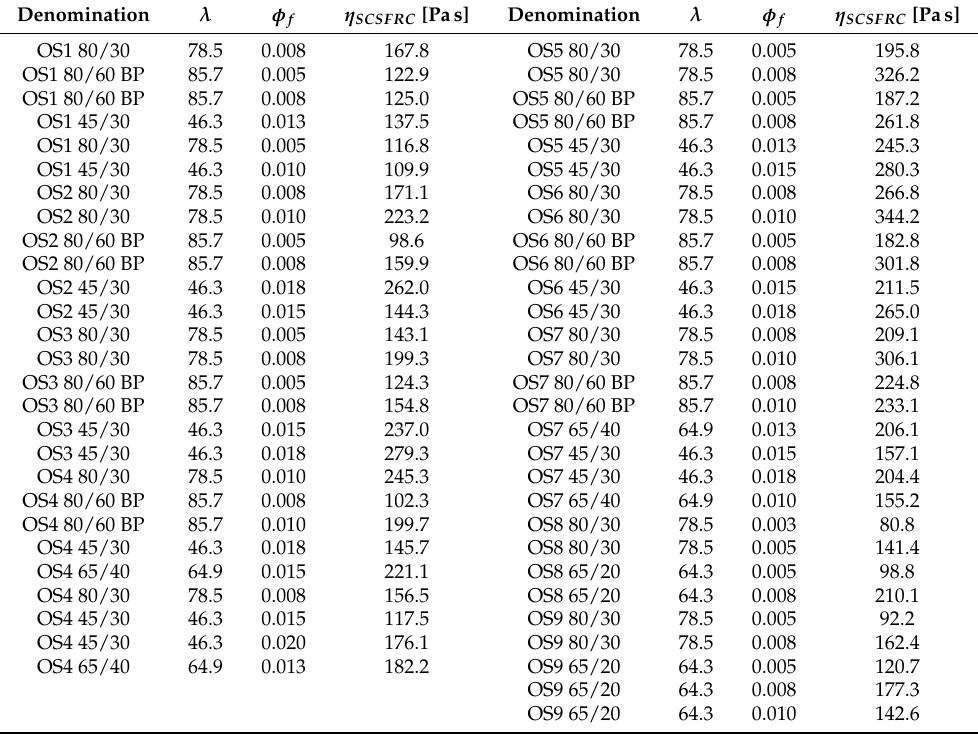
Table 2. λ , φ f and η SCSFRC of SCSFRC. Test set-up of measurements with BML–Viscometer